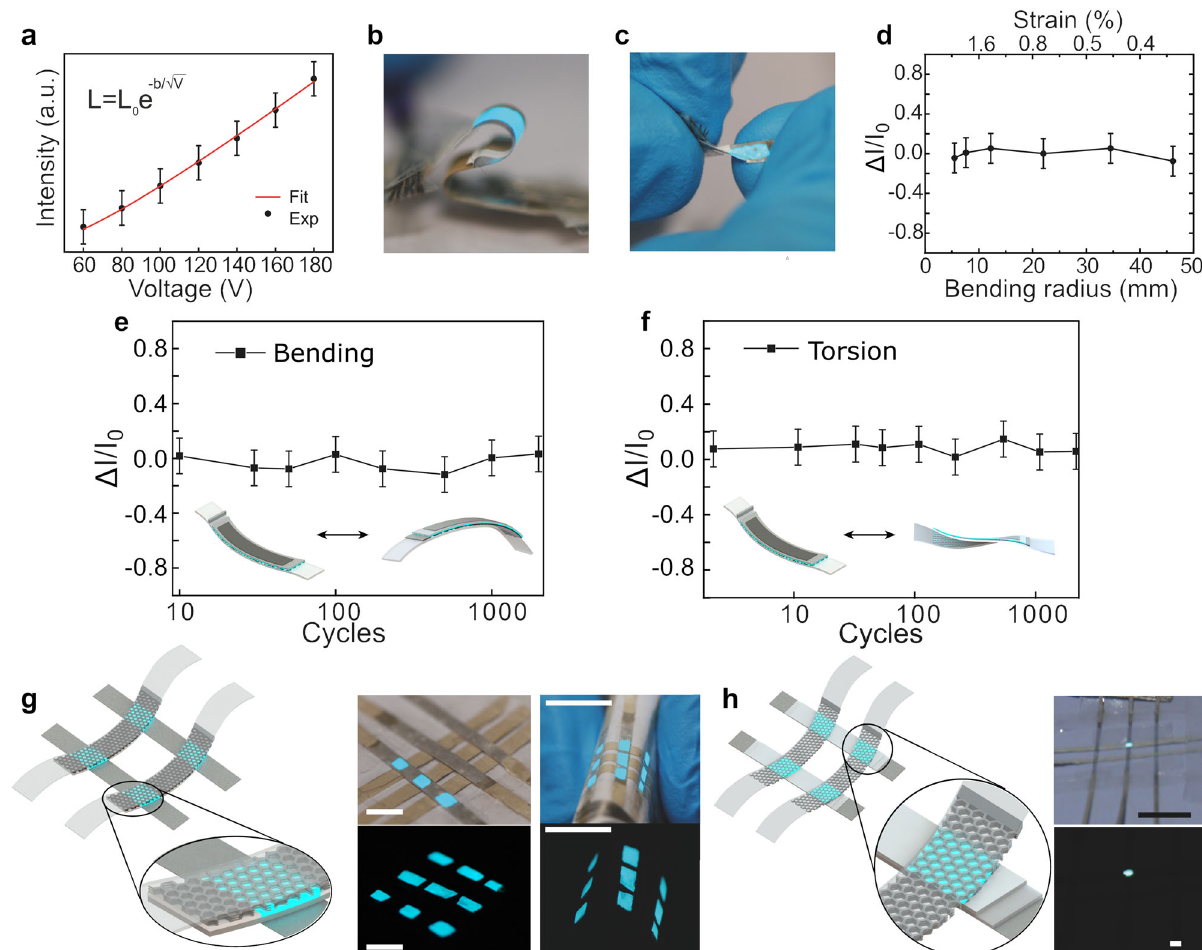
Fig. 3 ACEL devices on textile fi bres: a Intensity of the emitted light as a function of bias voltage fi tted to the Alfrey – Taylor relation between ACEL brightness ( L ) and voltage ( V ): L = L 0 exp( − b / V ) 1/2 , where L 0 and b are empirical constants, fi tted with the with good agreement ( R 2 = 0.9982). 34,35 Photograph of the device in bending b and torsion c . Change in emission as a function of: d the bending radius and corresponding fi bre strain; e repeated bending cycles; f repeated twisting cycles. Two approaches to ACEL arrays and corresponding photos in light and dark conditions: g large pixels (scale bars: left 5 mm; right 20 mm) and h small pixels (scale bars: top 10 mm; bottom 1